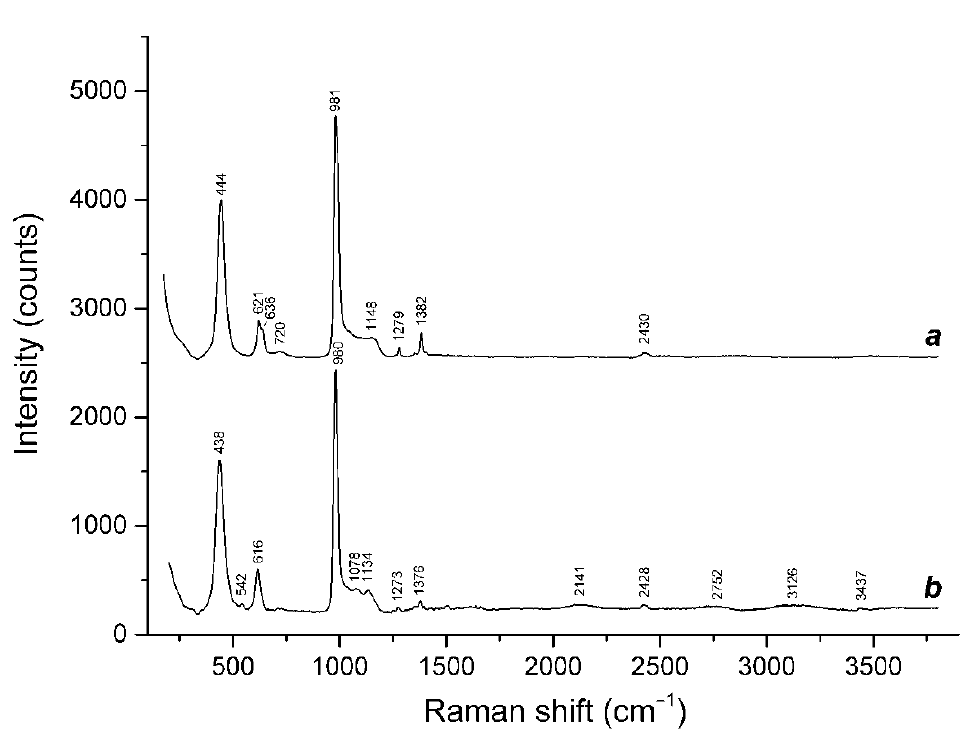
Figure 7. Raman spectra of the nosean Samples 7 ( a ) and 8 ( b ). The outer zones of nosean individuals (such as Sample 7) have a blue tint. The samples show intense luminescence with a maximum at 16,000 cm − 1 and a vibrational structure with phonon repetitions at a distance of 540 cm − 1 . This luminescence is caused by the S 2 • – radical anions (Figure 8).